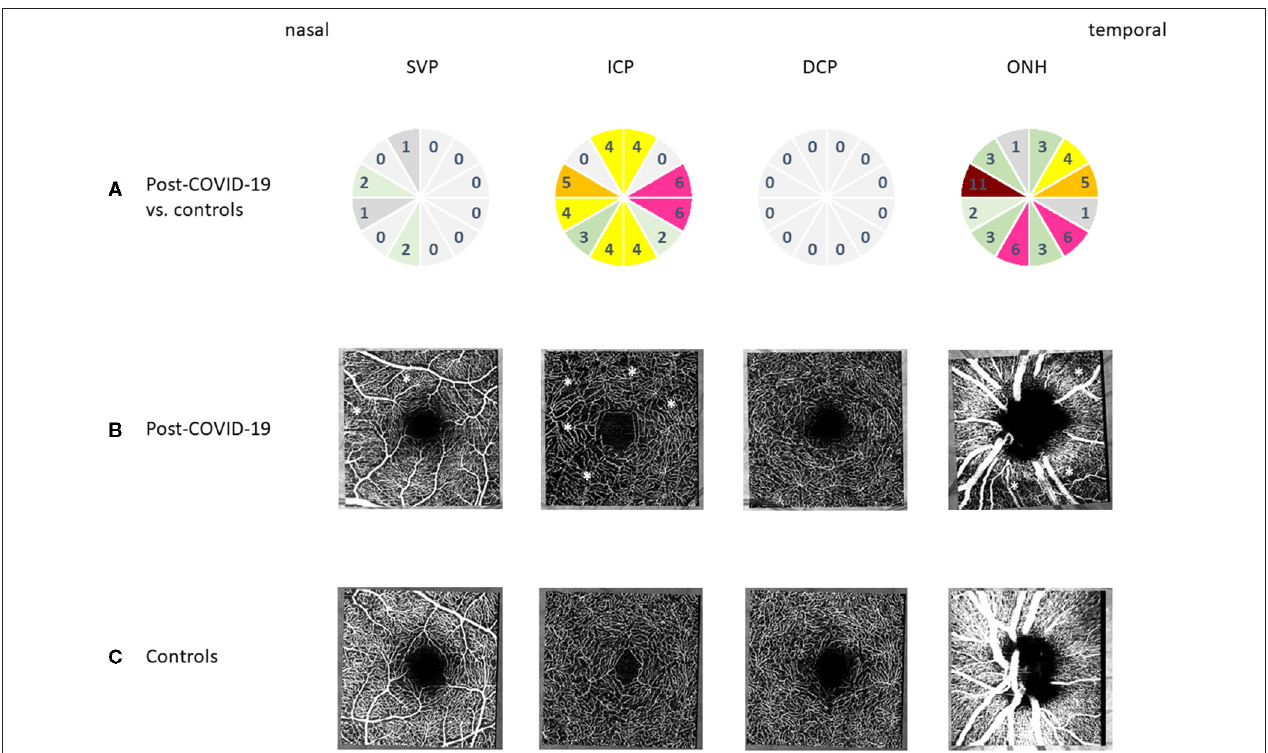
FIGURE 2 | Microcirculation of the macula and peripapillary regions after coronavirus disease 2019 (COVID-19) infection compared to controls: (A) qualitative analysis of the number of significant interactions between vessel density of each sector (s 1 -s 12 ) of macula optical coherence tomography angiography (OCT-A) in superficial vascular plexus (SVP), intermediate capillary plexus (ICP), and deep capillary plexus (DCP) and optic nerve head (ONH) by color coding (red, n ≥ 8; pink, n = 6–7; orange, n = 5; yellow, n = 4; green, n = 2–3; gray, n = 0–1) between controls and post-COVID-19 eyes. (B) Representative OCT-A scans of the macula (SVP, ICP, and DCP) and peripapillary regions after COVID-19 infection ( ⋆ Areas of reduced vessel density). (C) Representative OCT-A scans of the macula (SVP, ICP, and DCP) and peripapillary region in controls.